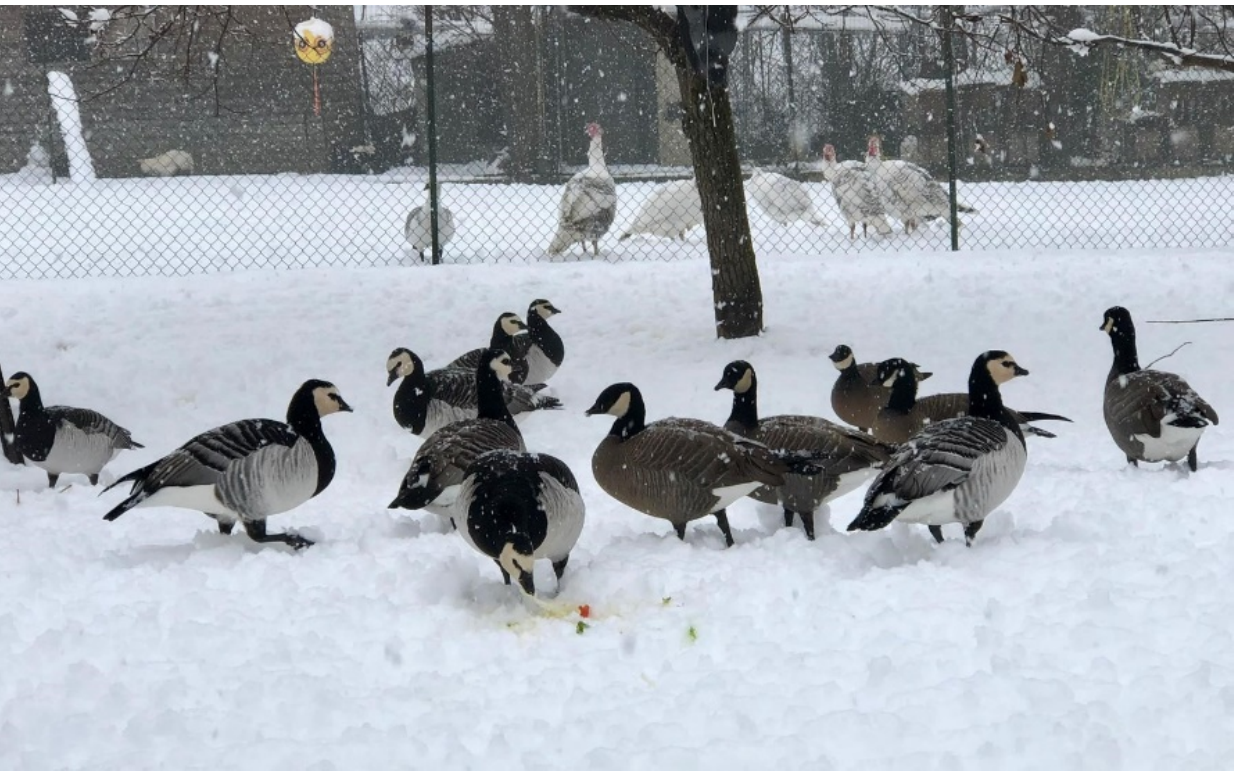
Figure 1. Group of Minor Canadian geese ( Branta hutchinsii ), Barred head geese ( Anser indicus ) and White-faced geese ( Brenta leucopsis ).